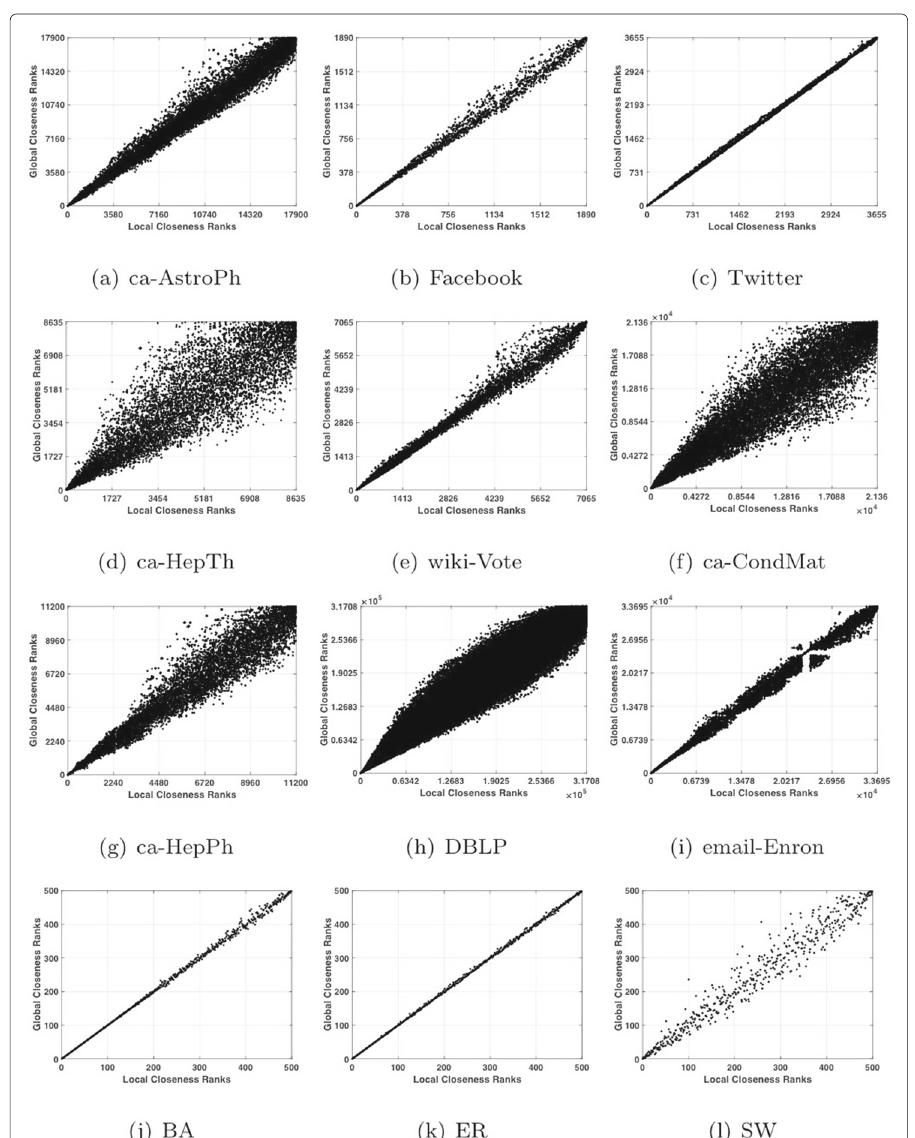
Fig. 2 Correlations between the nodes’ ranks provided by the proposed local metric and the global closeness centrality on synthetic and real-world networks. These two metrics correlate very well